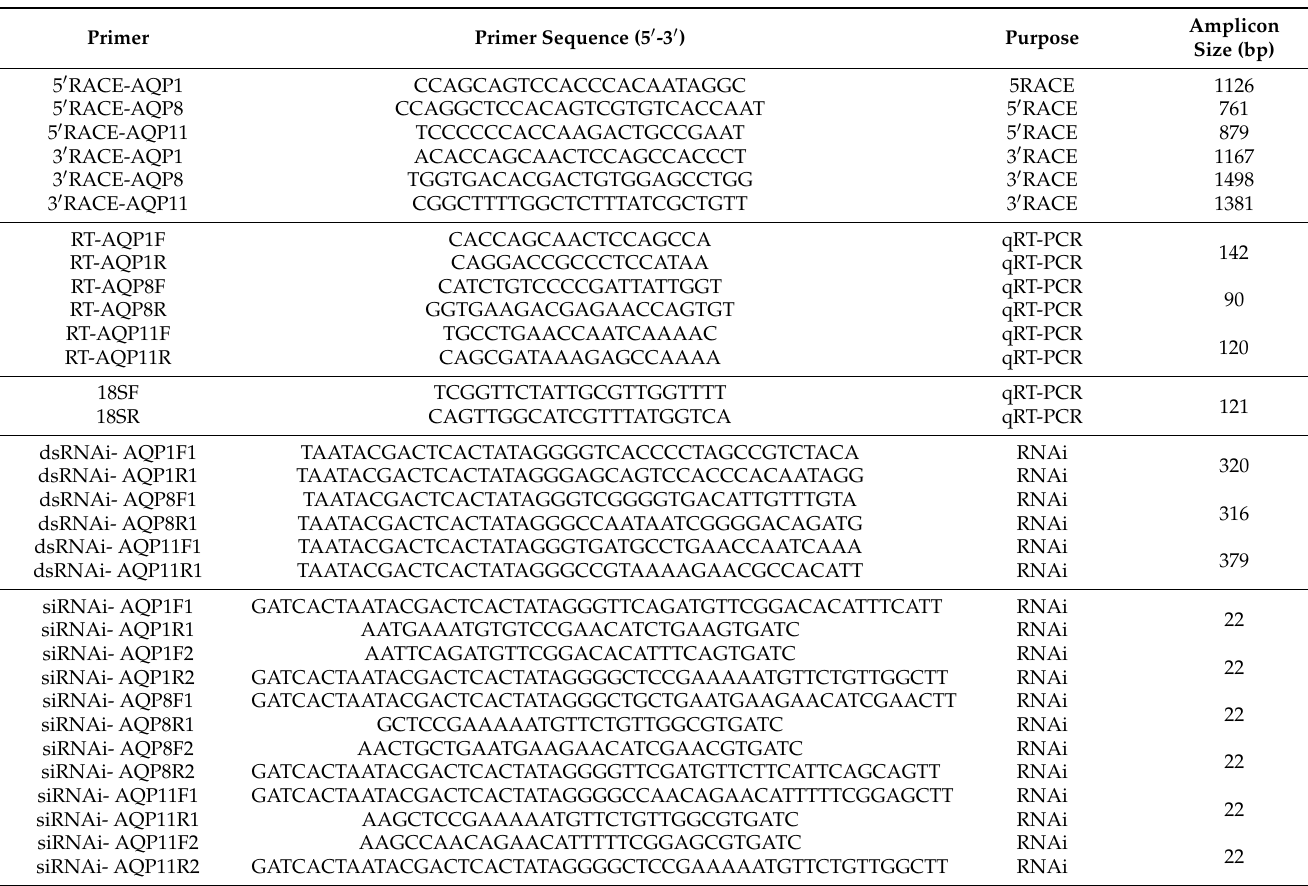
Table 1. Primers used for Sc-AQP1 , Sc-AQP8 , and Sc-AQP11 gene cloning; qRT-PCR; and RNA